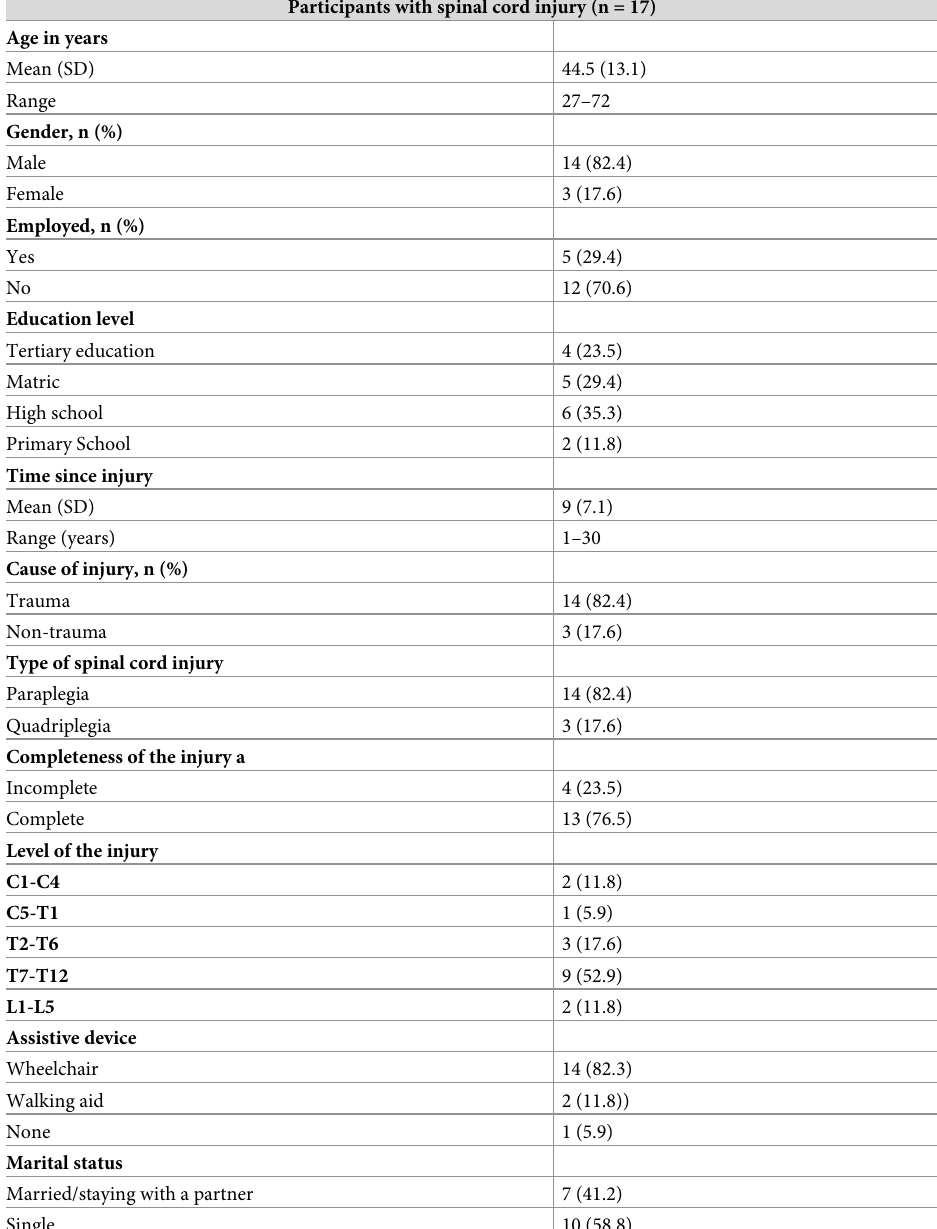
Table 1. Demographic profile of the participants with